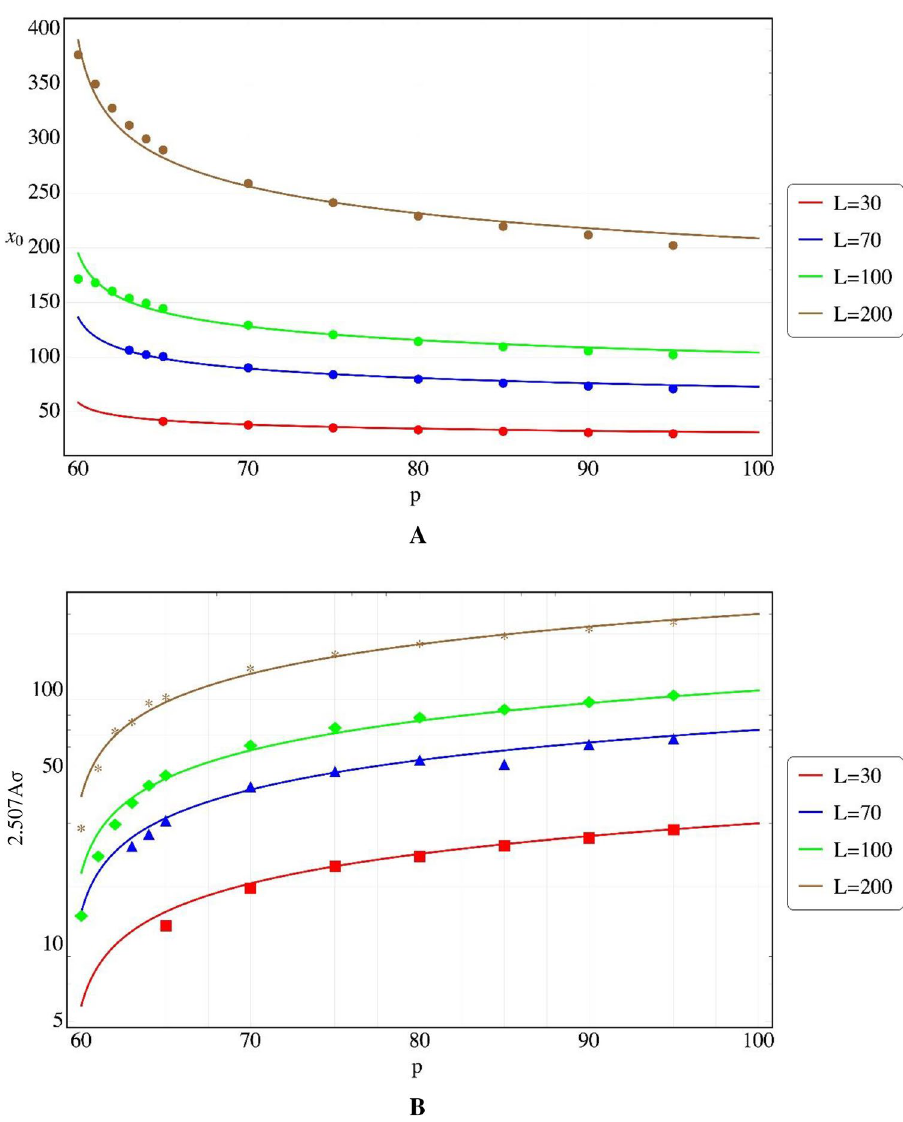
Figure 4. (Colors on line) Least square fits to Gaussian parameters of the output results near percolation threshold. ( A ) For x 0 . ( B ) For AT . Critical behavior is